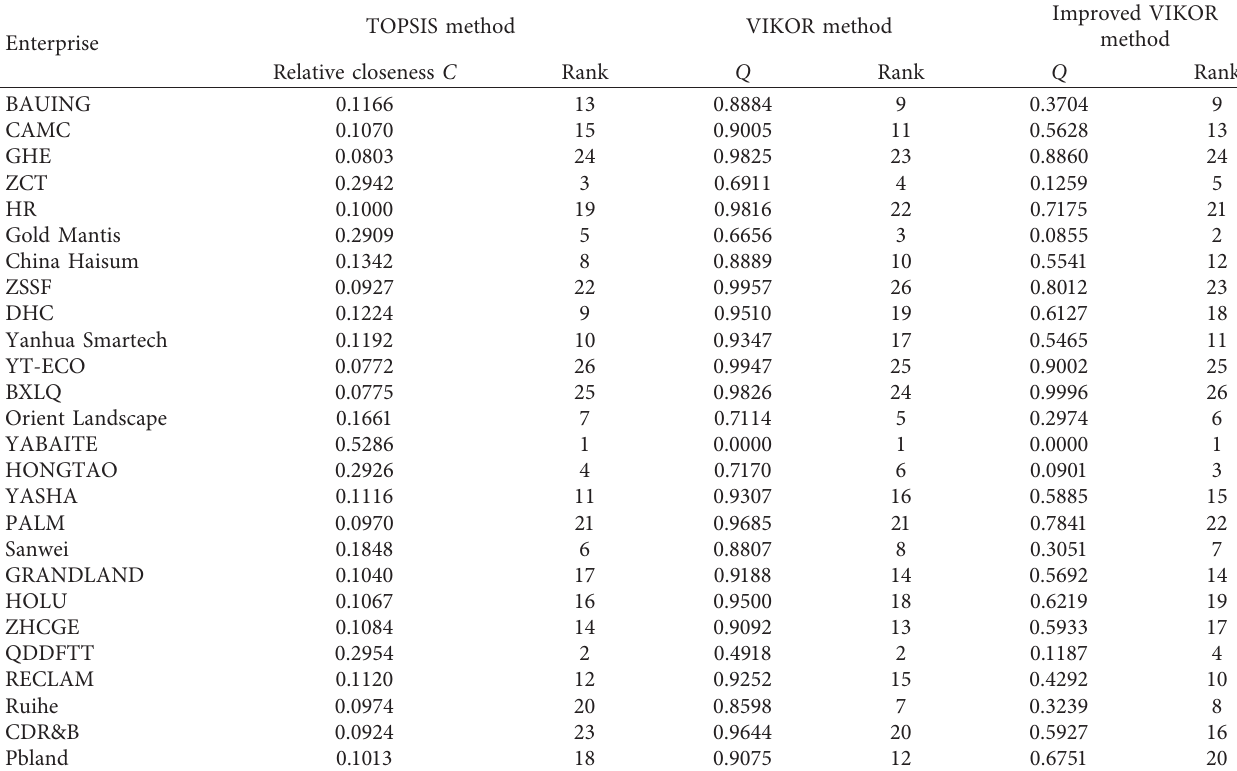
Table 5: Ranking results of each method in